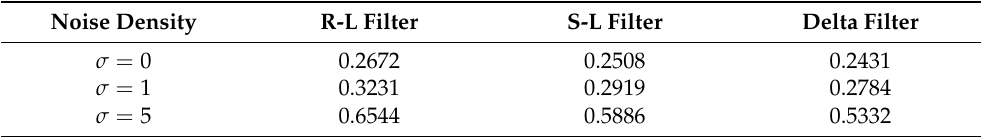
Table 1. RMSE of reconstructed